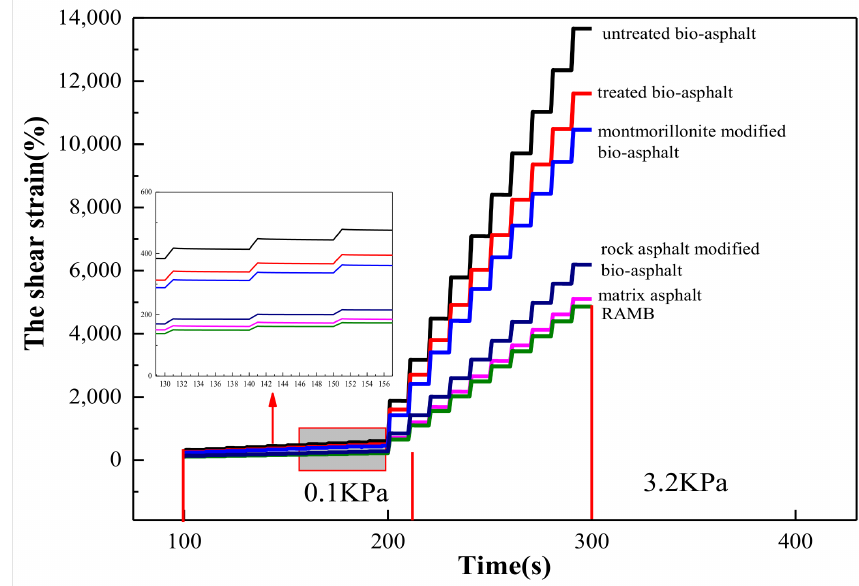
Figure 6. Shear strain figure of six asphalts at 58 ◦